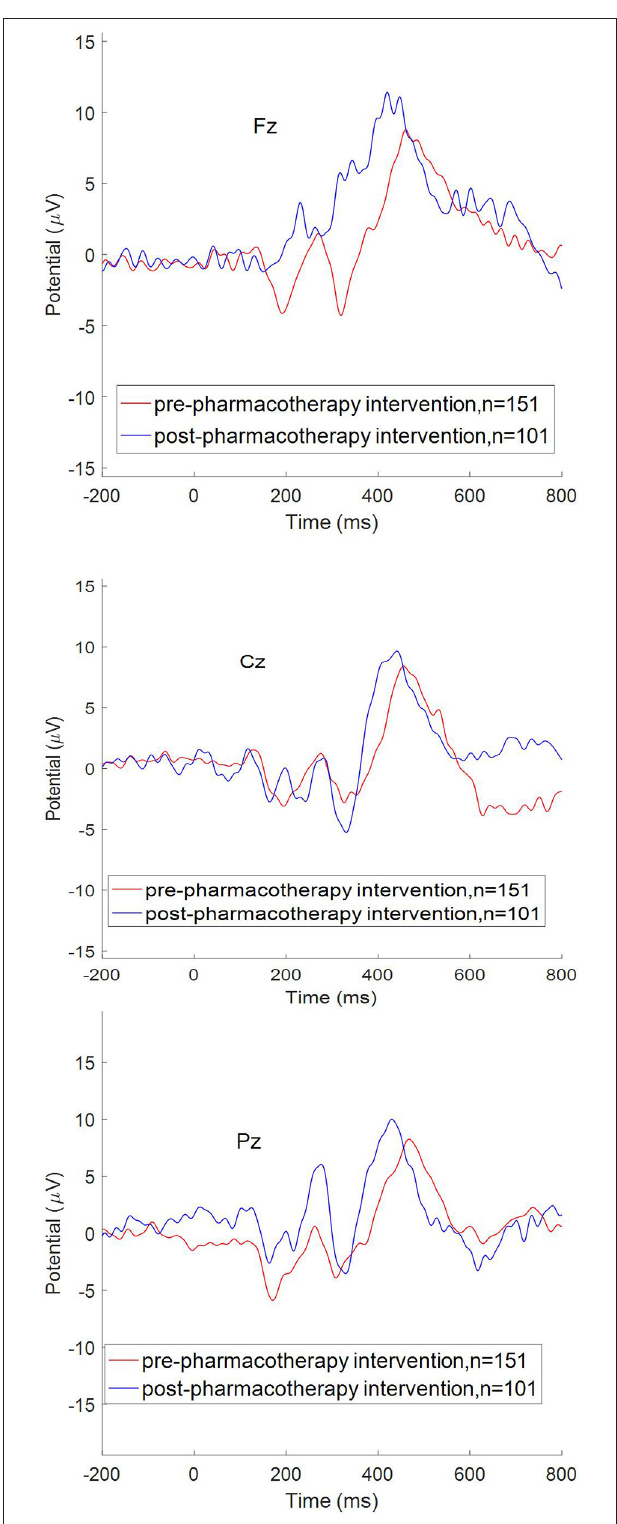
FIGURE 1 | P300 (Fz Cz Pz) pre-pharmacotherapy intervention and